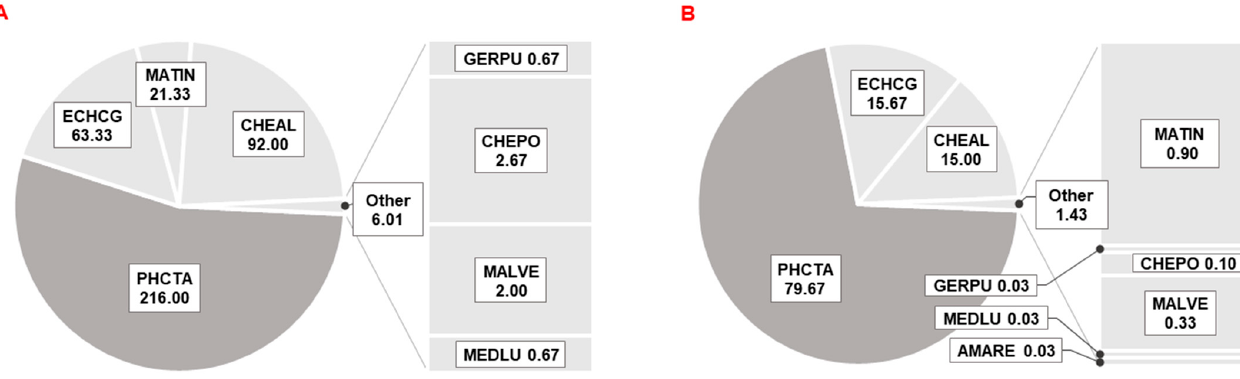
Figure A3. Number of plants per m 2 —Sowing 3 (10th of May) in 2018 ( A ) and leaf coverage in %—Sowing 3 (10th of May) in 2018 ( B ).